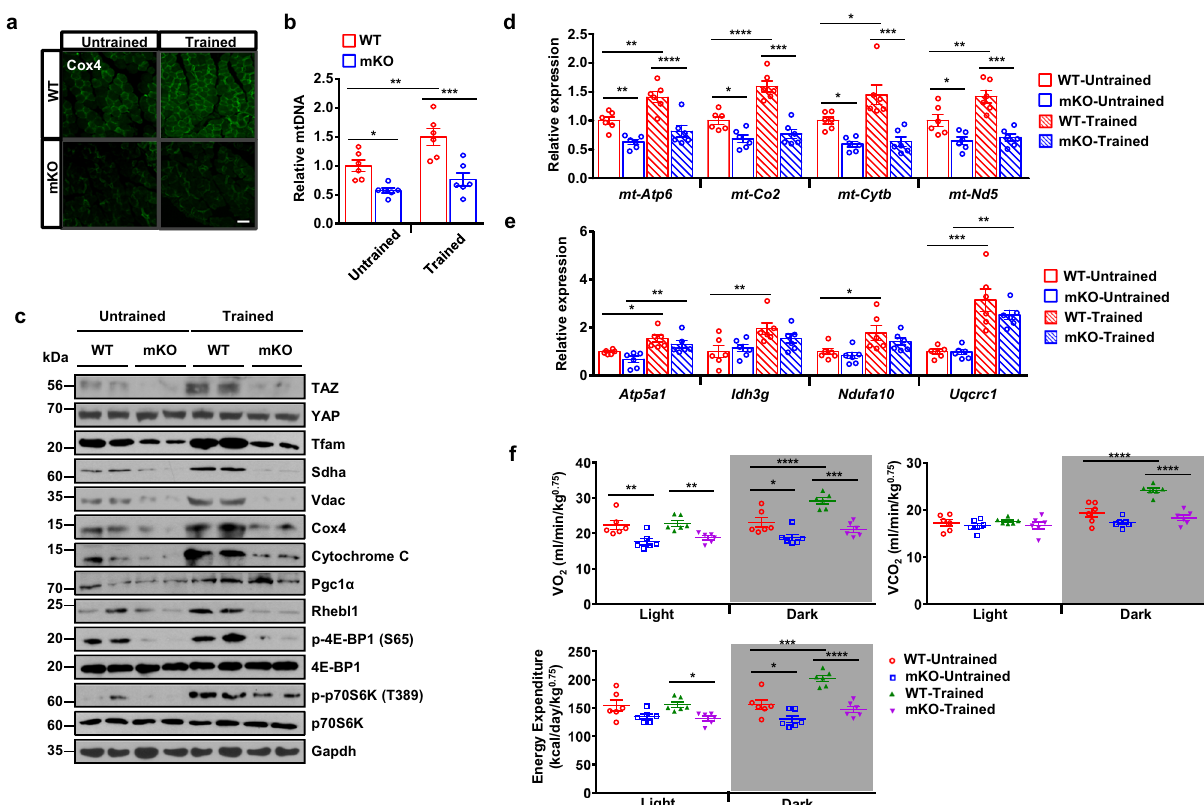
Fig. 5 TAZ stimulates exercise-induced mitochondrial biogenesis and increases respiratory metabolism and activity. a Wild-type (WT) and muscle- speci fi c TAZ knockout (mKO) mice were subjected to endurance exercise training. The gastrocnemius muscle obtained from these mice was isolated and embedded in paraf fi n. The sectioned tissues were immunostained with an anti-COX4 antibody to visualise the mitochondria. Scale bar = 50 μ m. b Genomic DNA was isolated from the gastrocnemius muscle of mice described in ( a ). Relative mitochondrial DNA copy number was determined via quantitative PCR using primers for mitochondrial-encoded Cox2 and nuclear-encoded β -globin . The Ct values of mitochondrial Cox2 were normalized to those of nuclear β -globin ; n = 6 for each genotype (WT untrained vs. mKO untrained; * p = 0.0188, WT untrained vs. WT trained; ** p = 0.0069, WT trained vs. mKO trained; *** p = 0.0002). c Protein from the gastrocnemius muscle of mice described in ( a ) was assessed via immunoblotting to observe the indicated proteins. GAPDH was used as the loading control. d RNA was isolated from the gastrocnemius muscle of mice described in ( a ). Mitochondrial-encoded marker gene expression was analysed via quantitative reverse transcription (qRT)-PCR, n = 6 for each genotype ( mt-Atp6 ; ** p = 0.0035 for WT untrained vs. mKO untrained, ** p = 0.0071 for WT untrained vs. WT trained, **** p < 0.0001 for WT trained vs. mKO trained, mt-Co2 ; * p = 0.0174 for WT untrained vs. mKO untrained, **** p < 0.0001 for WT untrained vs. WT trained, **** p < 0.0001 for WT trained vs. mKO trained, mt- Cytb ; * p = 0.0214 for WT untrained vs. mKO untrained, * p = 0.0124 for WT untrained vs. WT trained, **** p < 0.0001 for WT trained vs. mKO trained, mt- Nd5 ; * p = 0.0186 for WT untrained vs. mKO untrained, ** p = 0.0059 for WT untrained vs. WT trained, * * ** p < 0.0001 for WT trained vs. mKO trained). e Nuclear-encoded mitochondrial gene expression in the gastrocnemius muscle of mice in ( a ) was analysed via qRT-PCR, n = 6 for each genotype ( Atp5a1 ; * p = 0.0137 for WT u n trained vs. WT trained, ** p = 0.0048 for eKO untrained vs. eKO trained, Idh3g ; ** p = 0.0089 for WT untrained vs. WT trained, Ndufa10 ; * p = 0.0205 for WT untrained vs. WT trained, Uqcrc1 ; **** p < 0.0001 for WT untrained vs. WT trained, ** p = 0.0011 for mKO untrained vs. mKO trained). f The respiratory metabolism of mice described in ( a ) was analysed using the Oxylet system. Data are shown as the average values observed under light and dark conditions; n = 6 for each condition (VO 2 -light; ** p = 0.0033 for WT untrained vs. mKO untrained, ** p = 0.0098 for WT trained vs. mKO trained, VO 2 -dark; * p = 0.0146 for WT untrained vs. mKO untrained, *** p < 0.0007 for WT untrained vs. WT trained, **** p < 0.0001 for WT trained vs. mKO trained, VCO 2 -dark; **** p < 0.0001 for WT untrained vs. WT trained, **** p < 0.0001 for WT trained vs. mKO trained, Energy expenditure-light; * p = 0.0234 for mKO untrained vs. mKO trained, Energy expenditure-dark; * p = 0.021 for WT untrained vs. mKO untrained, *** p = 0.0001 for WT untrained vs. WT trained, **** p < 0.0001 for WT trained vs. mKO trained). Ten to twelve-week - old mice were used for all panels. Data are presented as mean ± SEM for ( b , d – f ). Statistical signi fi cance was analysed via two-way ANOVA with Sidak ’ s multiple comparison test. Representative data was shown and experiments were performed at least twice with similar results for ( a , c ). Source data are provided as a Source data fi